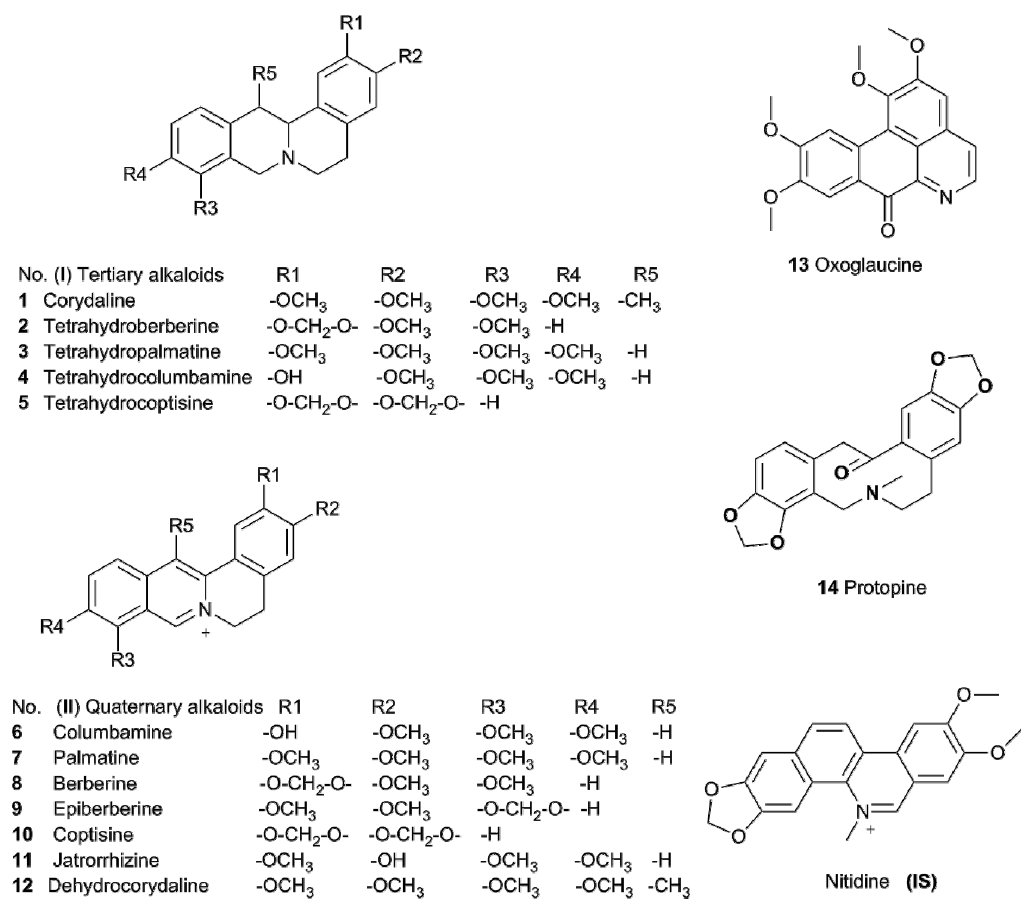
Figure 1. The chemical structures of the fourteen alkaloids and internal standard (IS). Table 1. MRM transitions and parameters of the fourteen alkaloids and IS.